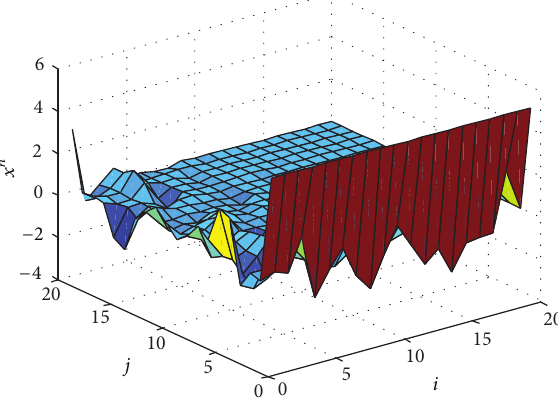
Figure 1: The trajectory of the state 𝑥 ℎ (𝑖,𝑗)